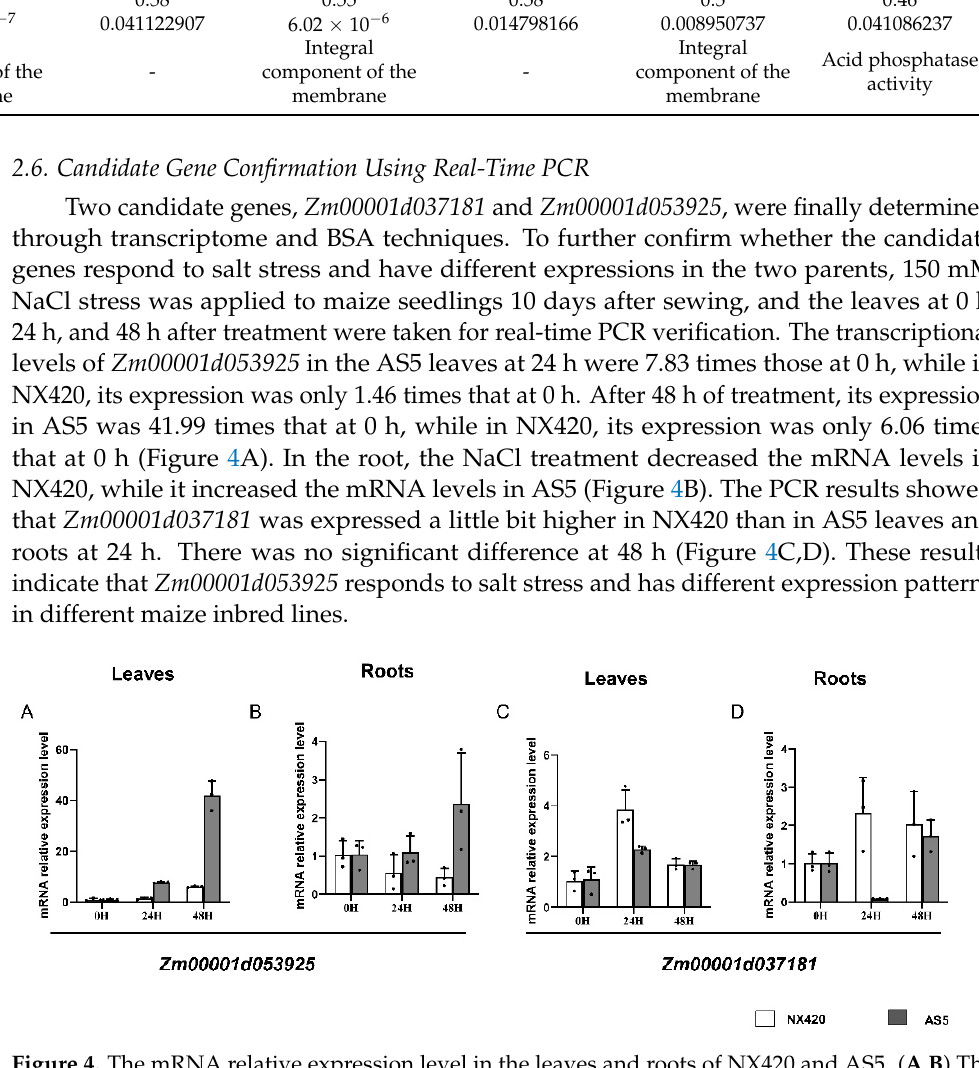
Figure 4. The mRNA relative expression level in the leaves and roots of NX420 and AS5. ( A , B ) The mRNA relative expression level of Zm00001d053925 in the leaves and roots; ( C , D ) the mRNA relative expression level of Zm00001d037181 in the leaves and roots.